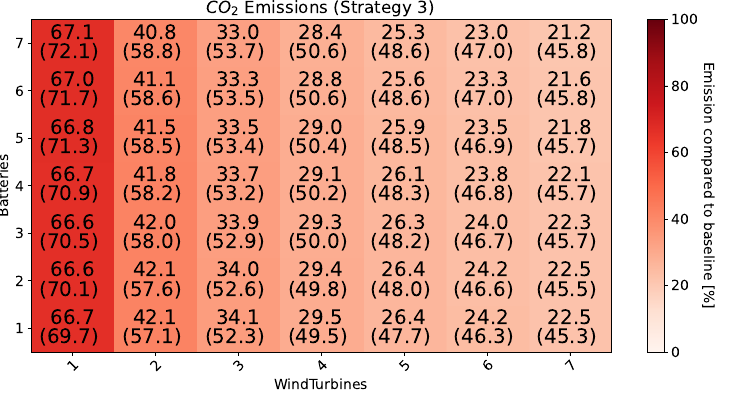
Figure 22. CO 2 emissions relative to baseline when the gas turbines can be turned off completely (0 emissions) or are kept idle with an emission rate of 0.5 kgs − 1 , shown in